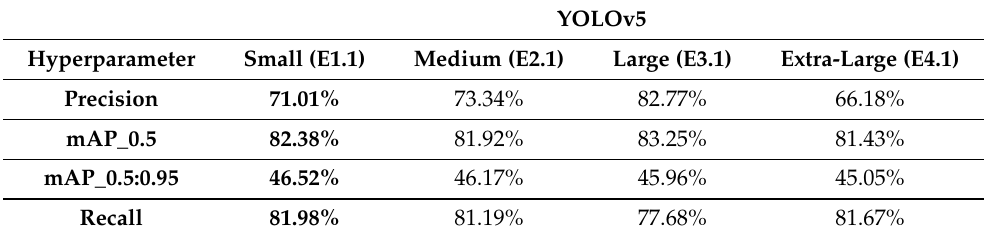
Table 6. Metrics obtained from trials in Table 5. Bold lines represent results for the selected model.